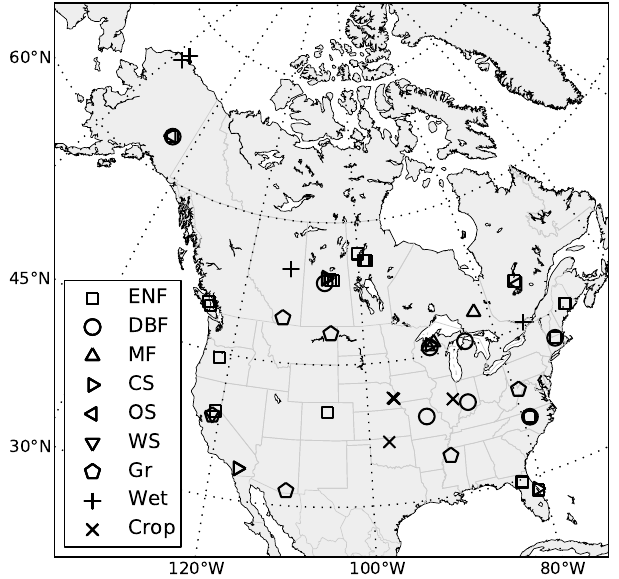
Fig. 1. The 65 eddy covariance flux tower sites from the Fluxnet network (http://www.fluxdata.org) that provide observations for VPRM parameterization and VPRM flux residual calculation. ENF: evergreen needleleaf forest, DBF: deciduous broadleaf forest, MF: mixed forest, CS: closed shrubland, OS: open shrubland, WS: woody savanna, Gr: grassland, Wet: permanent wetland, Crop: